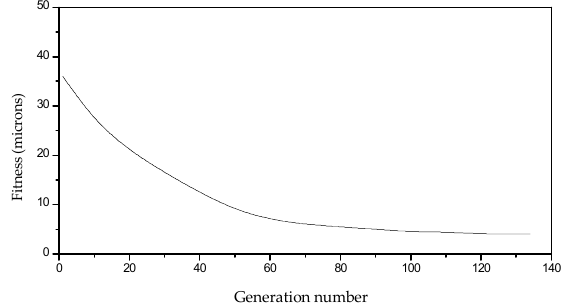
Figure 7. Fitness variation based on the number of generations.